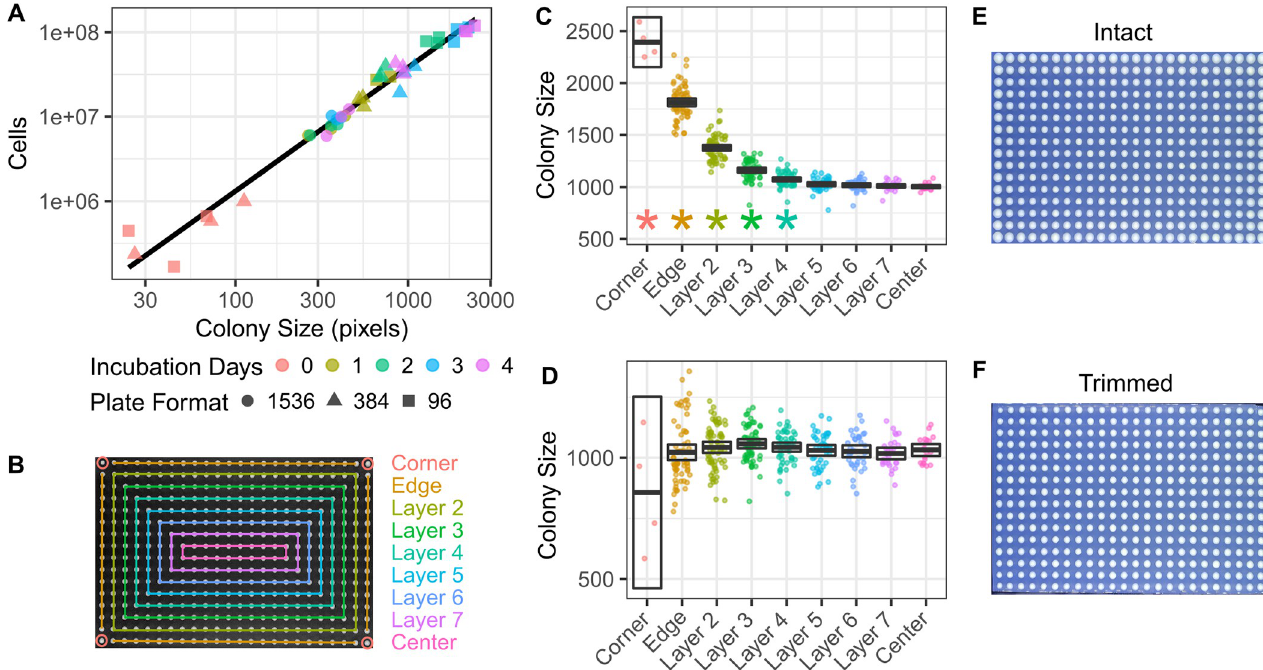
Fig 1. Estimating the number of cells per colony and minimizing edge effects. The relationship between cell number and colony size was best represented by the regression (black line) of log cells on log colony size for colonies grown at three different plate format densities and measured over four days of growth (A). Colony positions on the plate were modeled as a series of concentric layers with matched numbers of neighbors along the edges and corners (B). Colony sizes (in pixels) were quantified after 4 days growth with the edges either left intact (C) or trimmed (D). Boxes indicate the 95% confidence interval bisected by the mean. Stars indicate layers that are significantly different from the center (FDR < 0.05, two sample t-test). Photographs of the plates corresponding to the colony size plots for the intact and trimmed plates in panels C and D (E and F, respectively). All panels are from growth on CM plates.